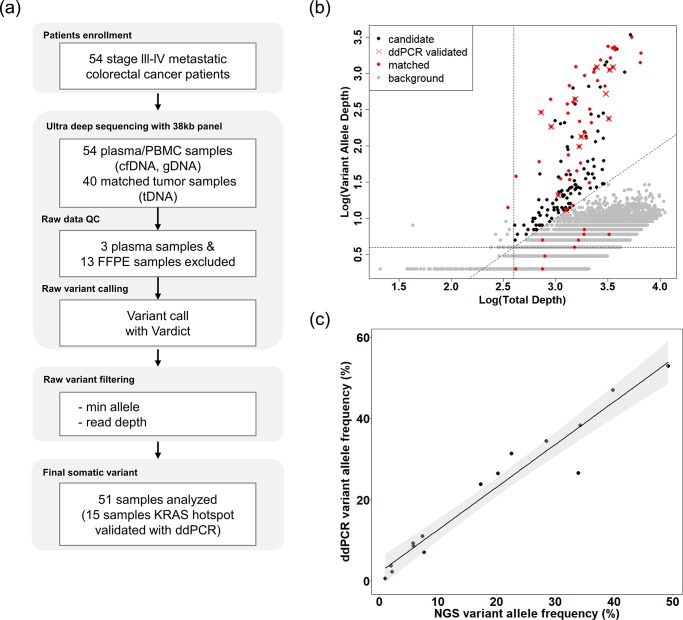
Complete NGS workflow for analysis of cfDNA, tumor tissue DNA, and PBMC DNA from patients with metastatic colorectal cancer.(A) Workflow for analysis of cfDNA and gDNA from tumor tissues and PBMC. (B) Analysis of biologic background in all somatic variants of plasma cfDNA. cfDNA variants concordant with matched tissue are shown in red. cfDNA variants validated with the ddPCR platform are indicated with an ‘X’. (C) Correlation between NGS and ddPCR results of cfDNA VAF (n = 15, R2 = 0.94, Pearson’s ρ = 0.97). cfDNA, cell-free DNA; ddPCR, droplet digital polymerase chain reaction; FFPE, formalin-fixed, paraffin-embedded; gDNA, genomic DNA; NGS, next-generation sequencing; PBMC, peripheral blood mononuclear cells; VAF, variant allele frequency.